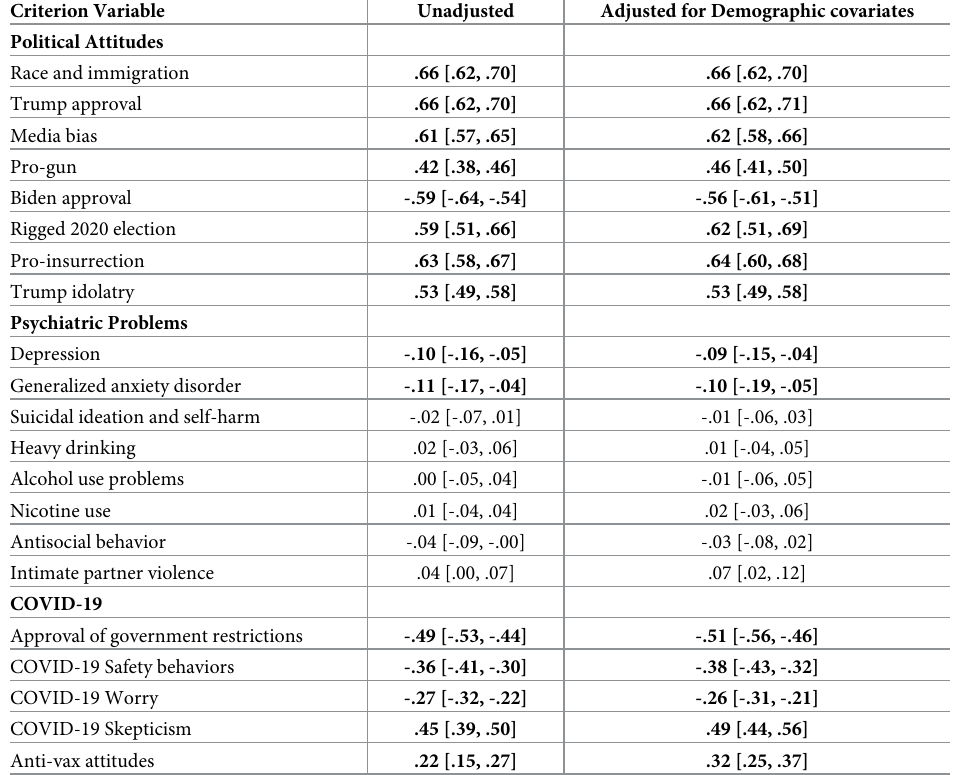
Table 4. Standardized regression coefficients and 95% confidence intervals for associations between random intercept factors for pro-police attitudes and time-varying